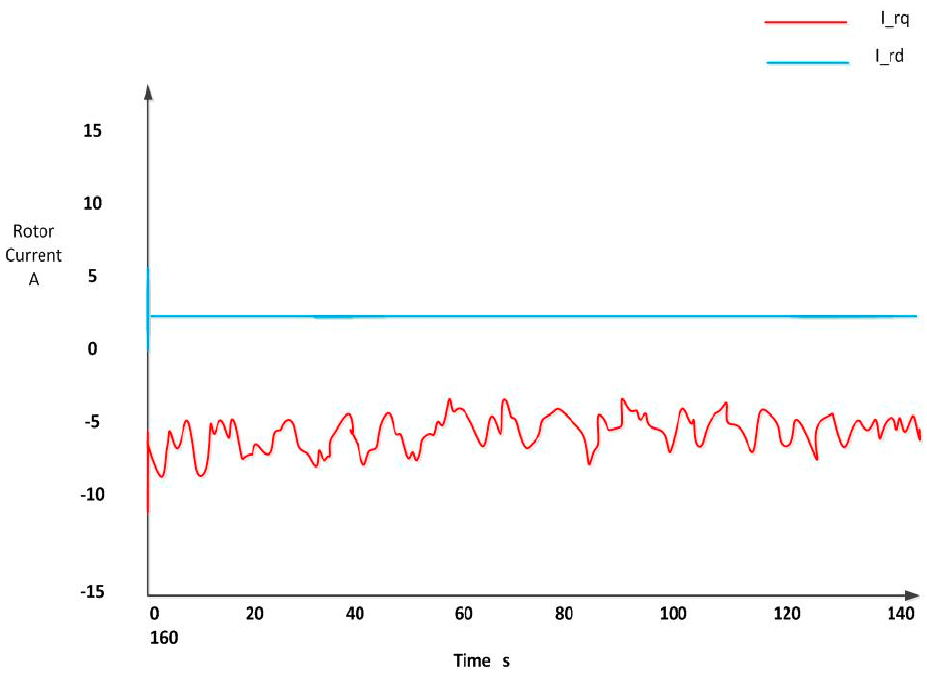
Figure 10. The DFIG rotor quadrature and direct voltages ( 𝑉 (cid:3045)(cid:3044) and 𝑉 (cid:3045)(cid:3031) ).